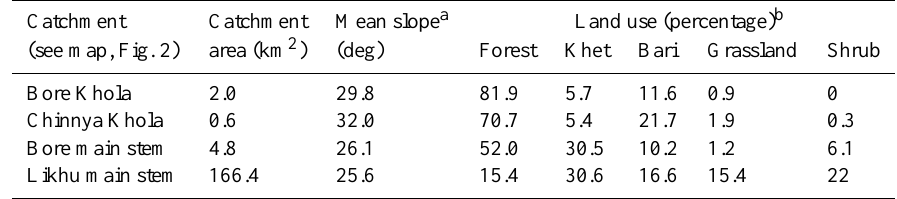
Table 1. Characteristics of the study catchments in the Likhu Khola. Catchment Catchment Mean slope a